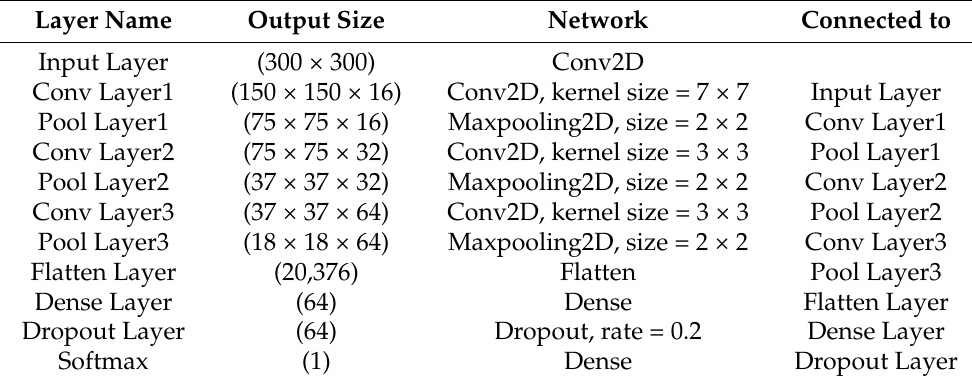
Table 2. Summary of Proposed Architecture.